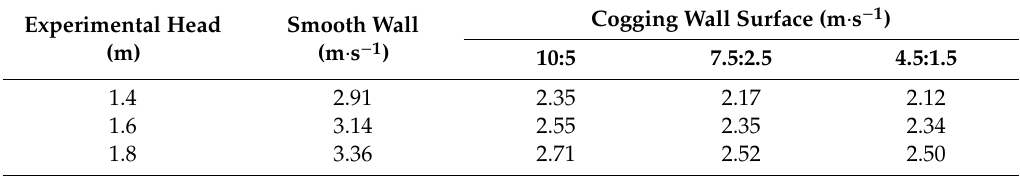
Table 1. Water head and corresponding velocity of each narrow channel overflow experimental section.